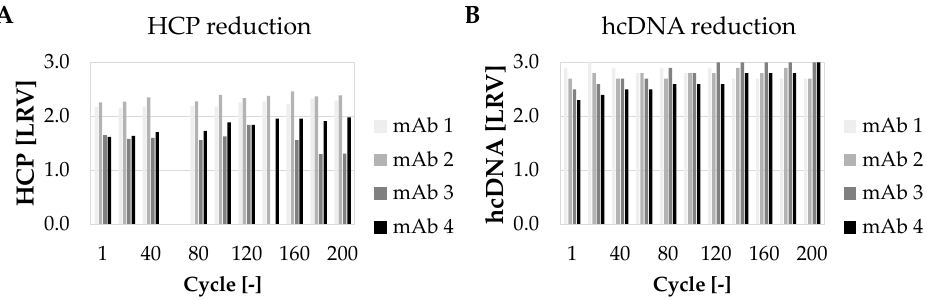
Figure 3. Capability of convecdiff membrane to reduce ( A ) HCP and ( B ) hcDNA (log reduction value; LRV) over 200 cycles. Shown is LRV for every 20th cycle (cycle 60 for HCP was not measured). HCCF values for each mAb: mAb 1 (HCP = 54004 ppm, hcDNA = 2320 ppm); mAb 2 (HCP = 48158 ppm, hcDNA = 4873 ppm); mAb 3 (HCP = 20233 ppm, hcDNA = 2360 ppm) and mAb 4 (HCP = 10305 ppm, hcDNA = 4750 ppm).